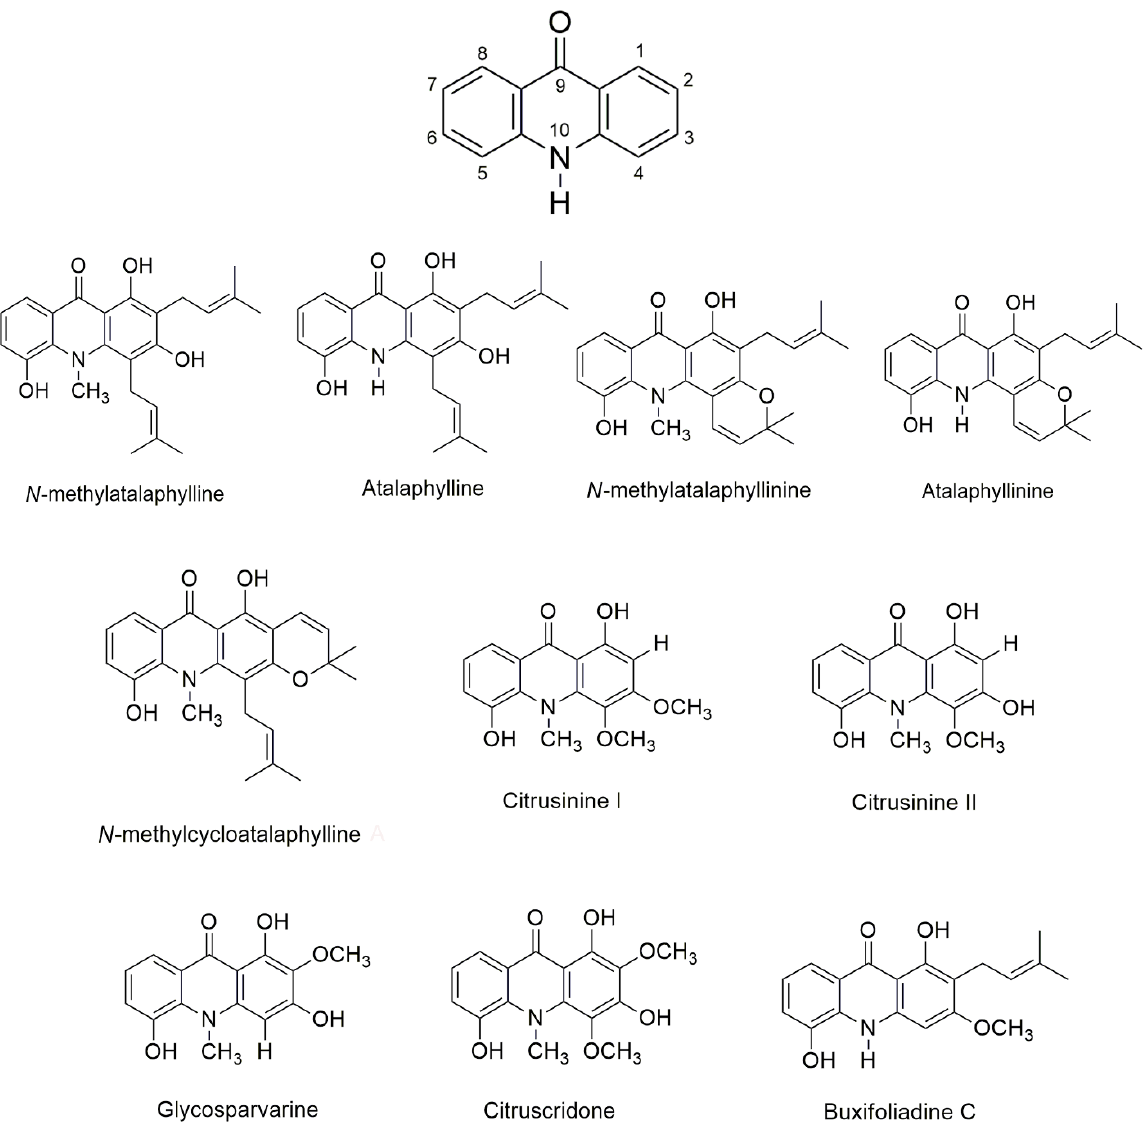
Figure 1. Structure of acridone